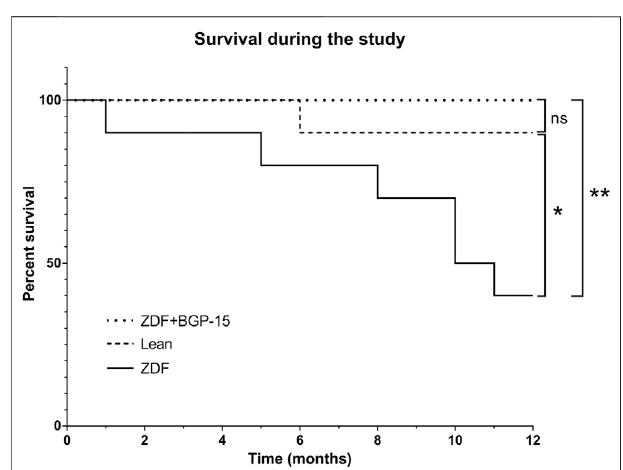
FIGURE 2 | Survival of animals during the 12 months of the study. Sixty percent of the untreated ZDF animals died during the study, which is a signi fi cant difference compared to healthy lean animals (10% death) or BGP- treated ZDF group (100% survival) (* p < 0.05 and ** p < 0.01, respectively). There was no signi fi cant difference between lean and ZDF + BGP-15 groups based on Mantel – Cox and Gehan – Breslow – Wilcoxon